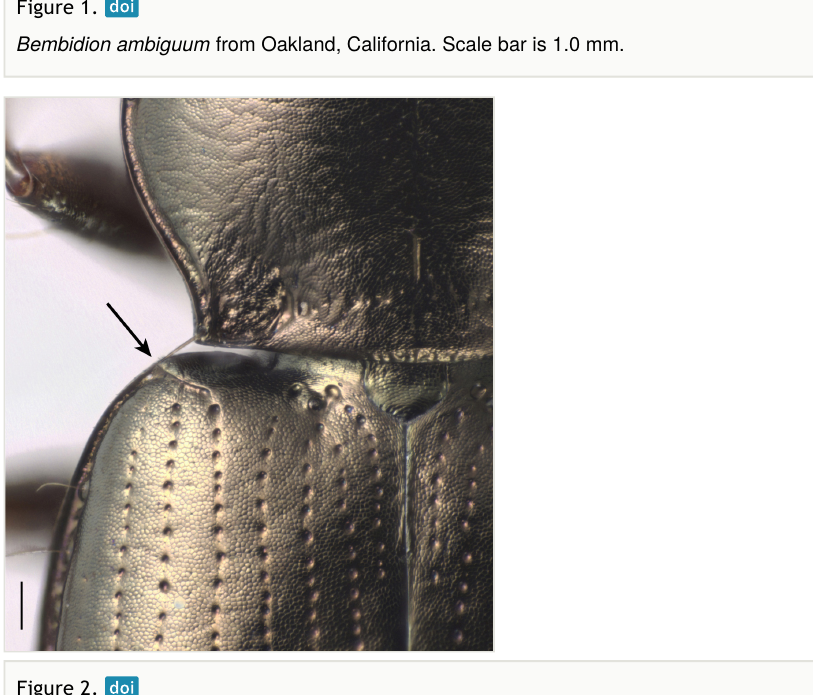
Figure 2. Bembidion ambiguum , closeup of shoulder of elytron, showing the angled margin. The arrow points to the vertex of the angle. Scale bar is 0.1